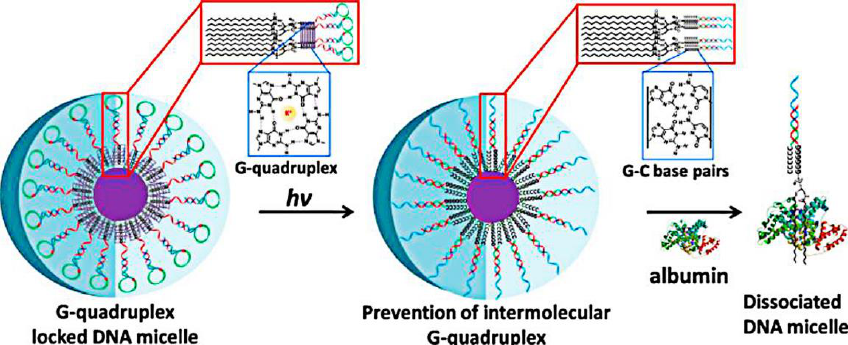
Figure 1. Schematic illustration of stability-tunable DNA – lipid micelles. DNA strand contains a G- rich sequence, which could form intermolecular G-quadruplex and dissociate at UV light.